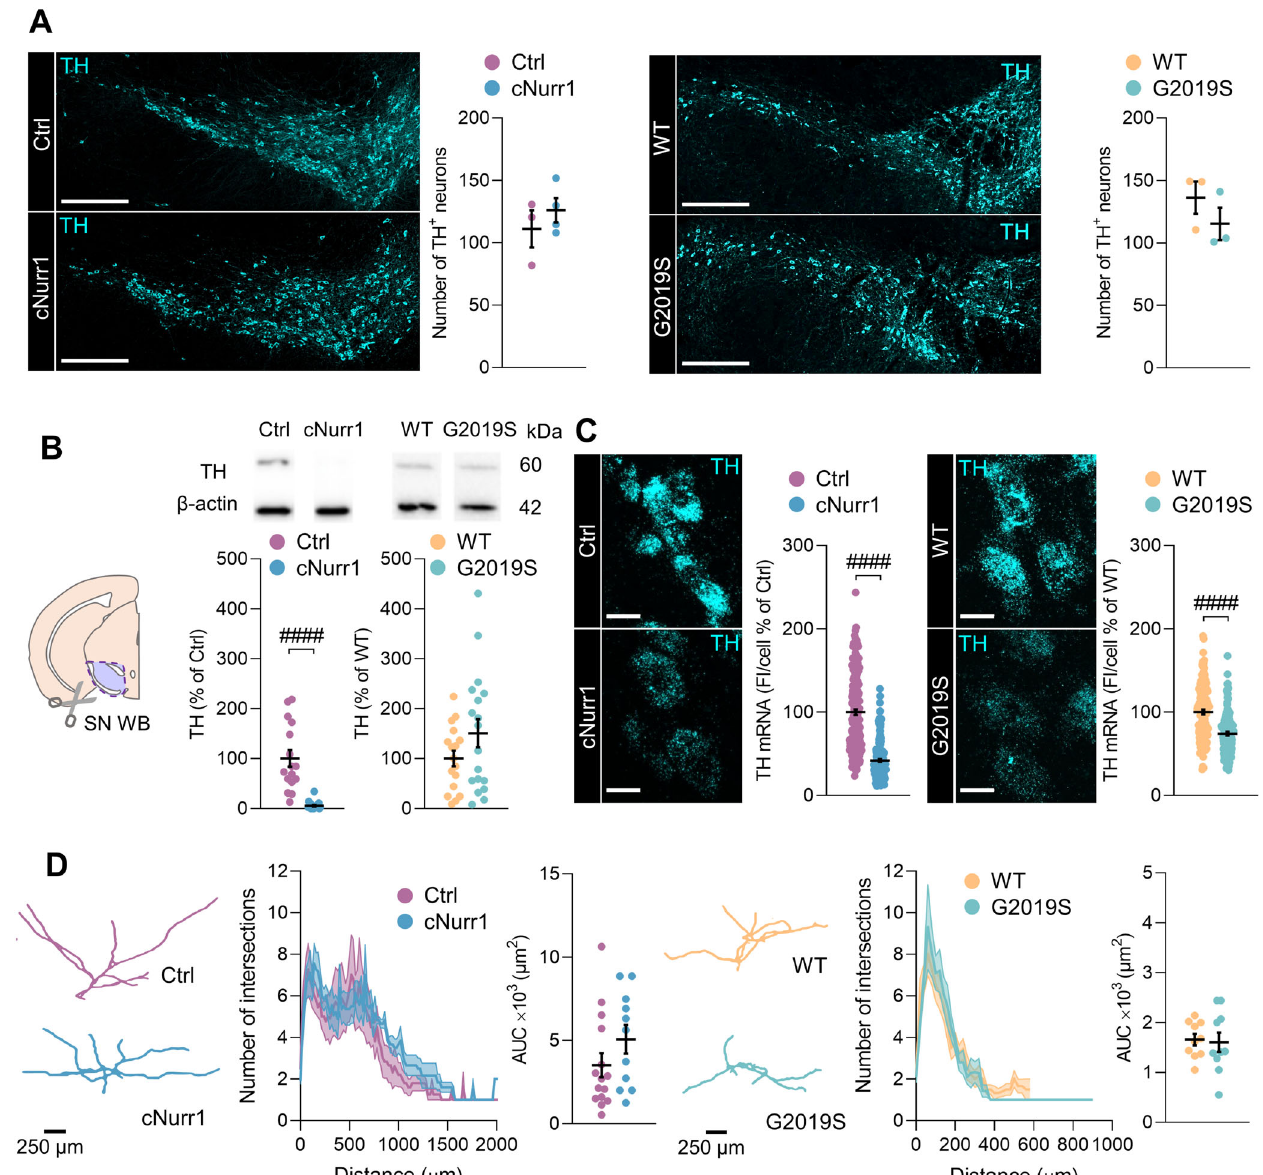
Fig. 2 SNc-DA neurons in cNurr1 and G2019S mice have intact cell count and morphology but display reduced TH mRNA. A TH immuno fl uorescence in midbrain sections containing the SNc; scale bars, 500 µm. Number of TH-positive neurons in the SNc of N = 3 Ctrl, 4 cNurr1, 3 WT and 3 G2019S mice. B Western blotting of TH in the ventral midbrain region containing the SNc of N = 16 Ctrl, 19 cNurr1, 17 WT and 18 G2019S mice. #### P < 0.0001; Mann – Whitney U -test. C Representative images of neurons in the SNc from FISH experiments of TH mRNA; scale bars, 15 µm. Quanti fi cation of fl uorescence in individual TH-containing cells in the SNc. n = 186, 185, 135, 126 TH-positive neurons from N = 3 Ctrl, 3 cNurr1, 3 WT and 3 G2019S mice. #### P < 0.0001; Mann – Whitney U -test. D Representative drawings illustrating the dendritic arborization of neurobiotin-injected neurons in the SNc of Ctrl, cNurr1, WT and G2019S mice. Sholl analysis shows the number of intersections and area under the curve (AUC) measured in n = 15, 11, 10, 10 neurobiotin-injected neurons from N = 6 Ctrl, 8 cNurr1, 4 WT and 4 G2019S